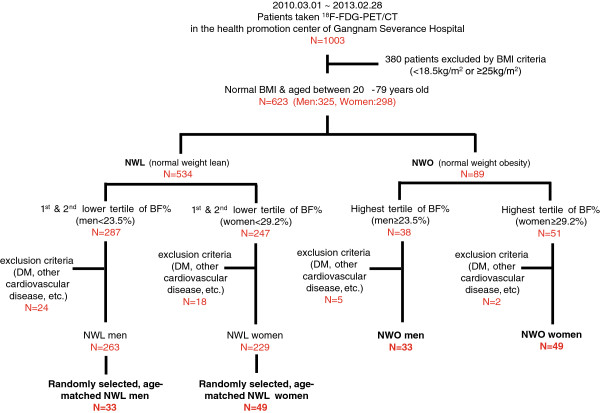
Schematic diagram and the process of the registration of subjects. 18 F-FDG-PET/CT, 18 F-fludeoxyglucose positron emission tomography/computed tomography; BMI, body mass index; NWL, normal weight lean; NWO, normal weight obesity; BF, body fat; DM, diabetes mellitus.